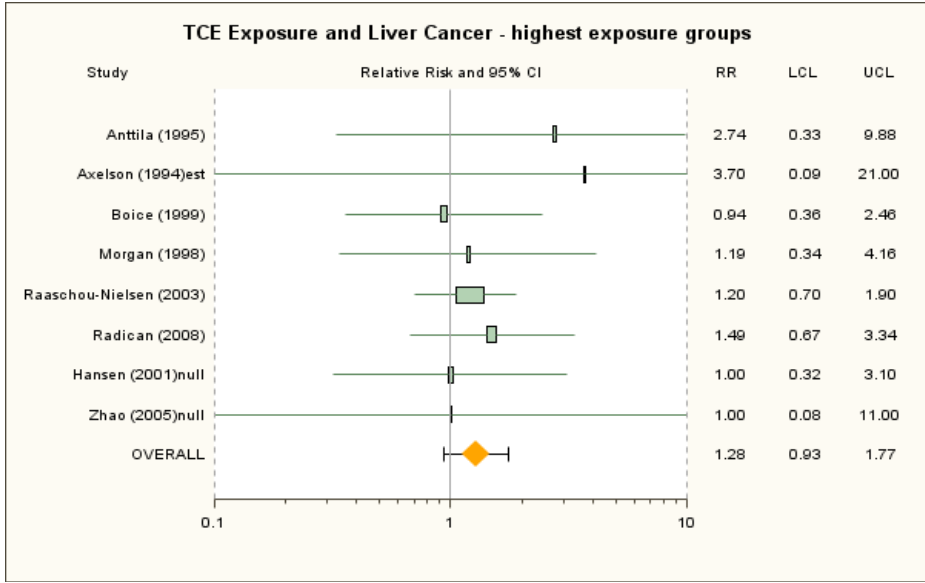
Figure 4. Forest plot of highest TCE exposure group and liver cancer from random-effects meta-analysis. Individual study results are plotted with 95% confidence intervals. A risk estimate of 1.0 is assigned for highest exposure in Hansen et al . [39] and Zhao et al . [25] to account for presumed reporting bias. Symbol sizes reflect relative weights of the 8 cohort